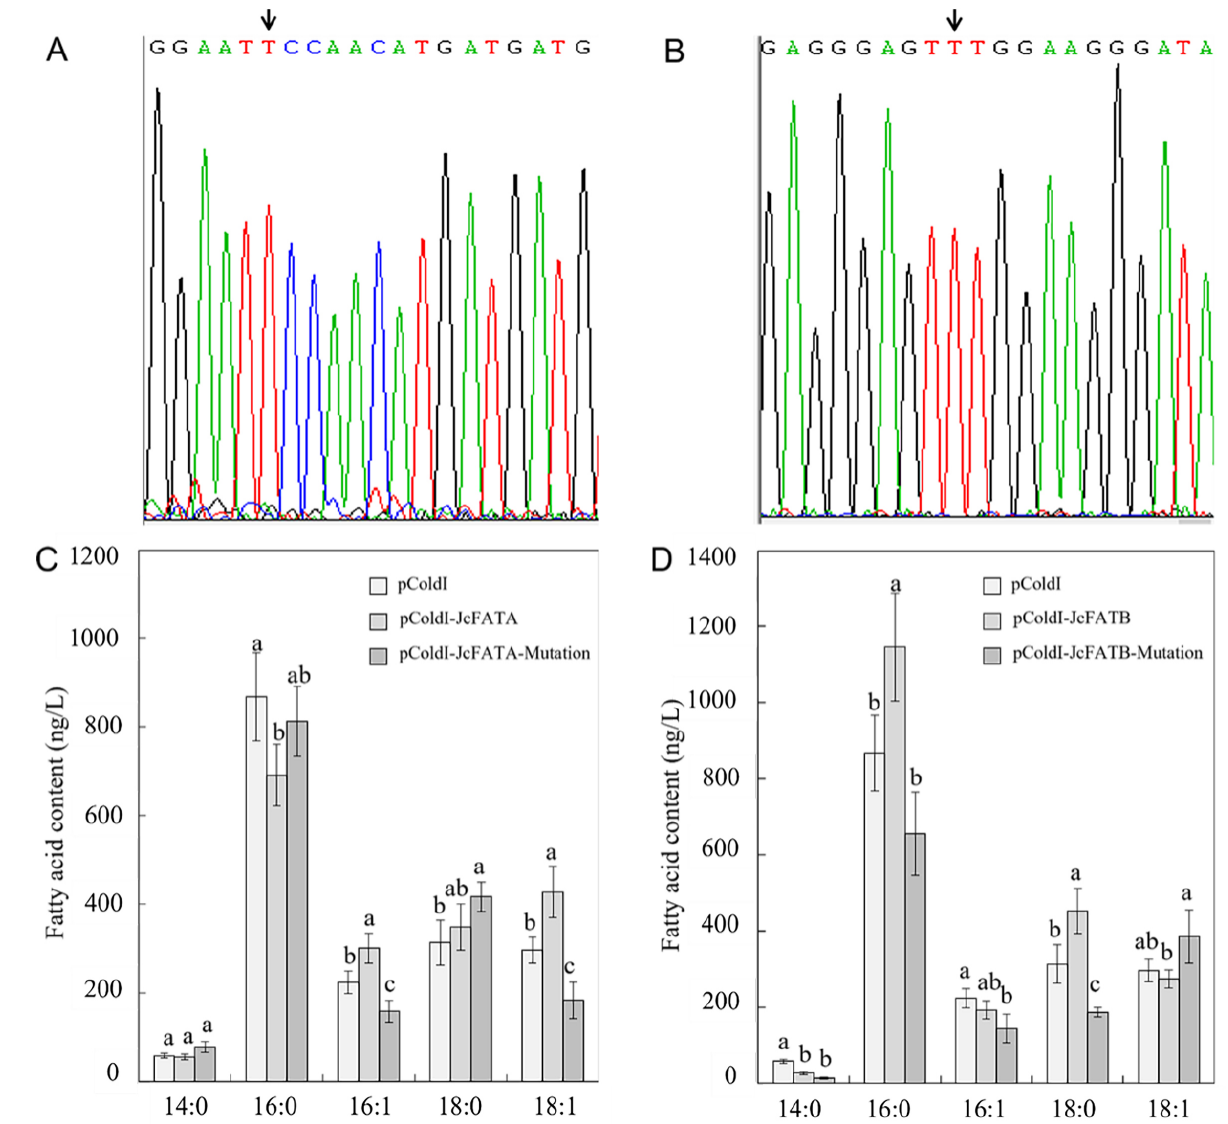
Figure 3. Analysis of the conserved catalytic active sites of JcFATA and JcFATB by prokaryotic expression. ( A , B ) Determination of the site-specific mutagenesis of JcFATA ( A ) and JcFATB ( B ), where the small black arrow indicates the mutated nucleotides and their sequencing peaks. ( C , D ) Analysis of the fatty acid contents of E. coli clones expressing wild-type JcFATA and JcFATB , and their mutant versions (JcFATA-Mutation and JcFATB-Mutation), respectively. pCold I was used as the prokaryotic expression vector. Each value in ( C , D ) was the mean of three measurements. Error bars = SD (standard deviation). Data within a column followed by different letters (a, b, and c) are significantly different at p ≤ 0.05 as determined by Duncan’s multiple range test.